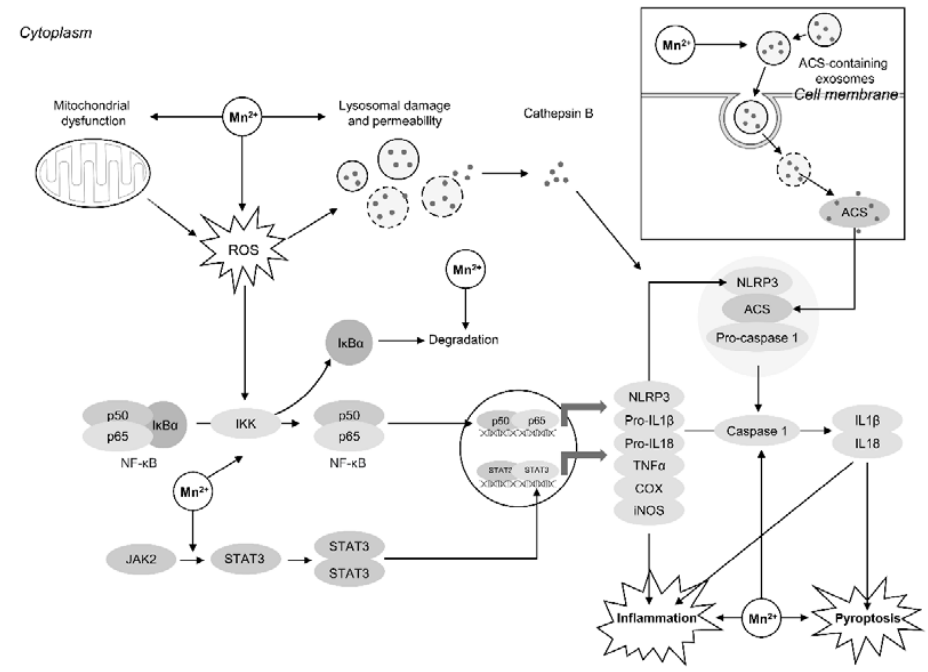
Figure 1. Neuroinflammatory effects of Mn exposure. NF- κ B activation through a number of mech-